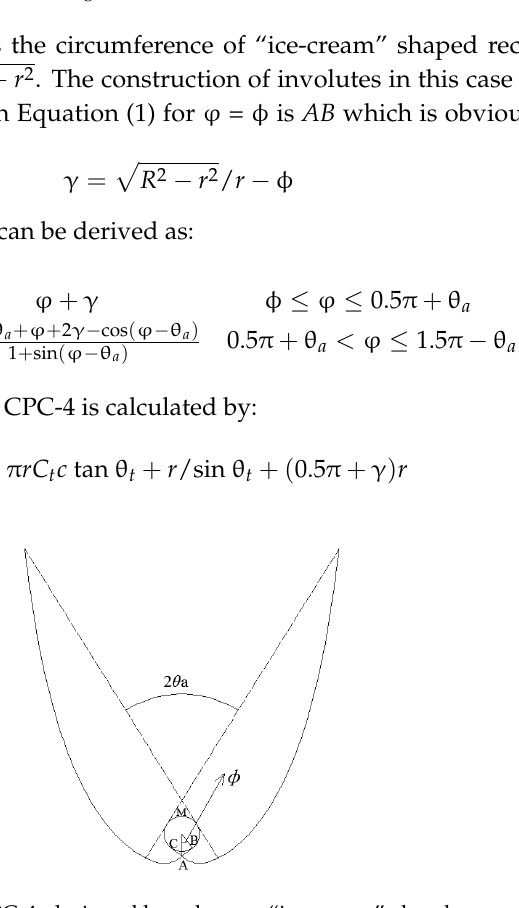
Figure 5. CPC ‐ 4, designed based on an “ice ‐ cream” absorber. Figure 5. CPC-4, designed based on an “ice-cream”